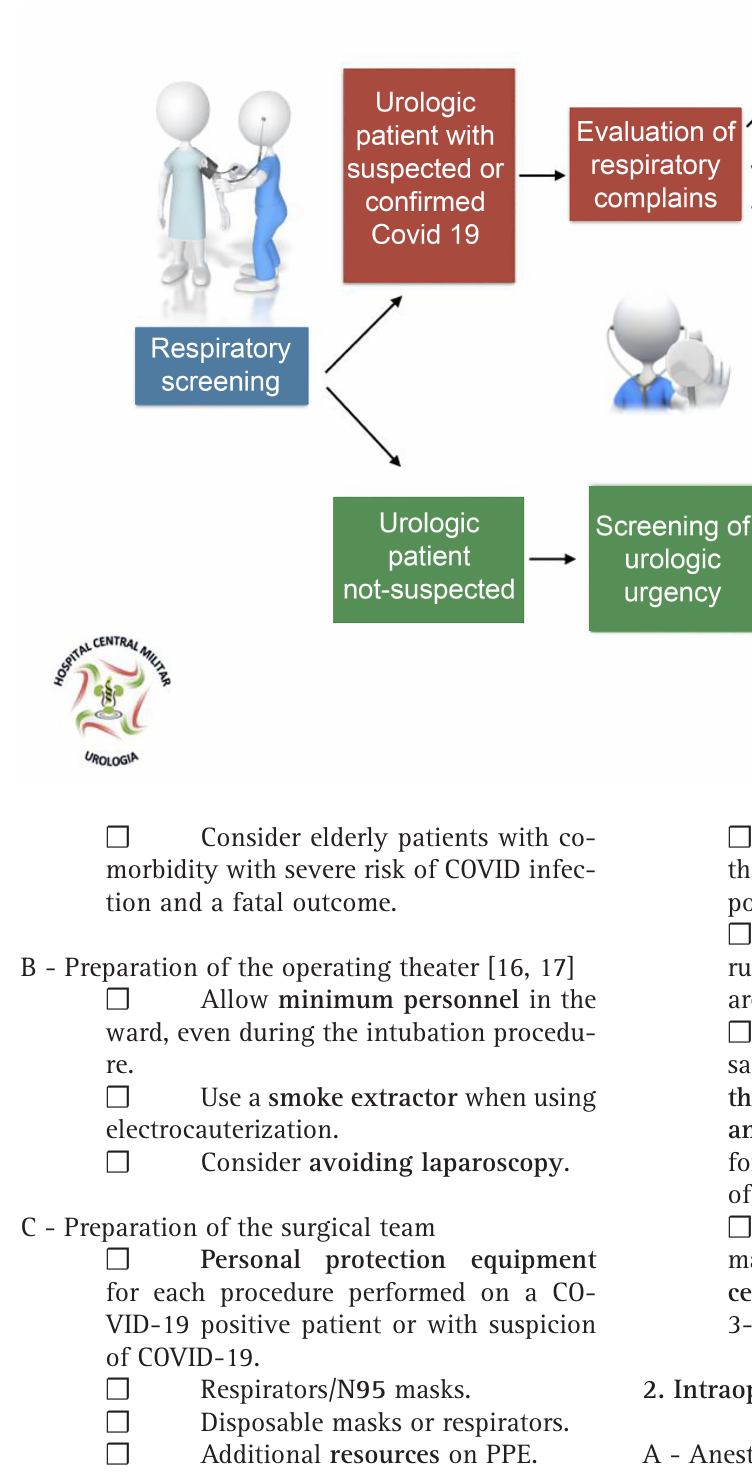
Figure 1 - Approach to patients with suspected urologic emergency or with confirmed diagnosis of COVID-19 at the department of Urgency of the Hospital Central